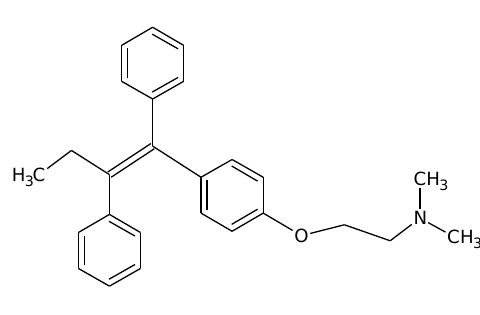
Figure 1. Structure of